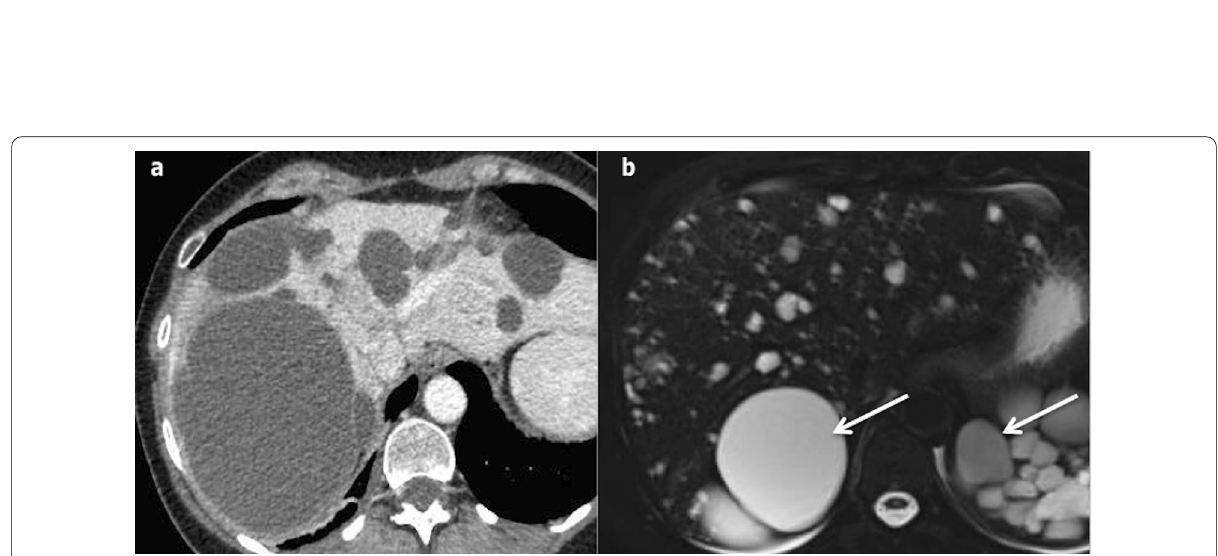
Fig. 15 Autosomal dominant polycystic kidney disease in a 38-year-old male patient. a Axial computed tomography on portal venous phase and b axial T2-weighted magnetic resonance imaging show several simple hepatic cysts and also numerous kidney cysts (arrows), with fluid signal (hypodense/hyperintense on